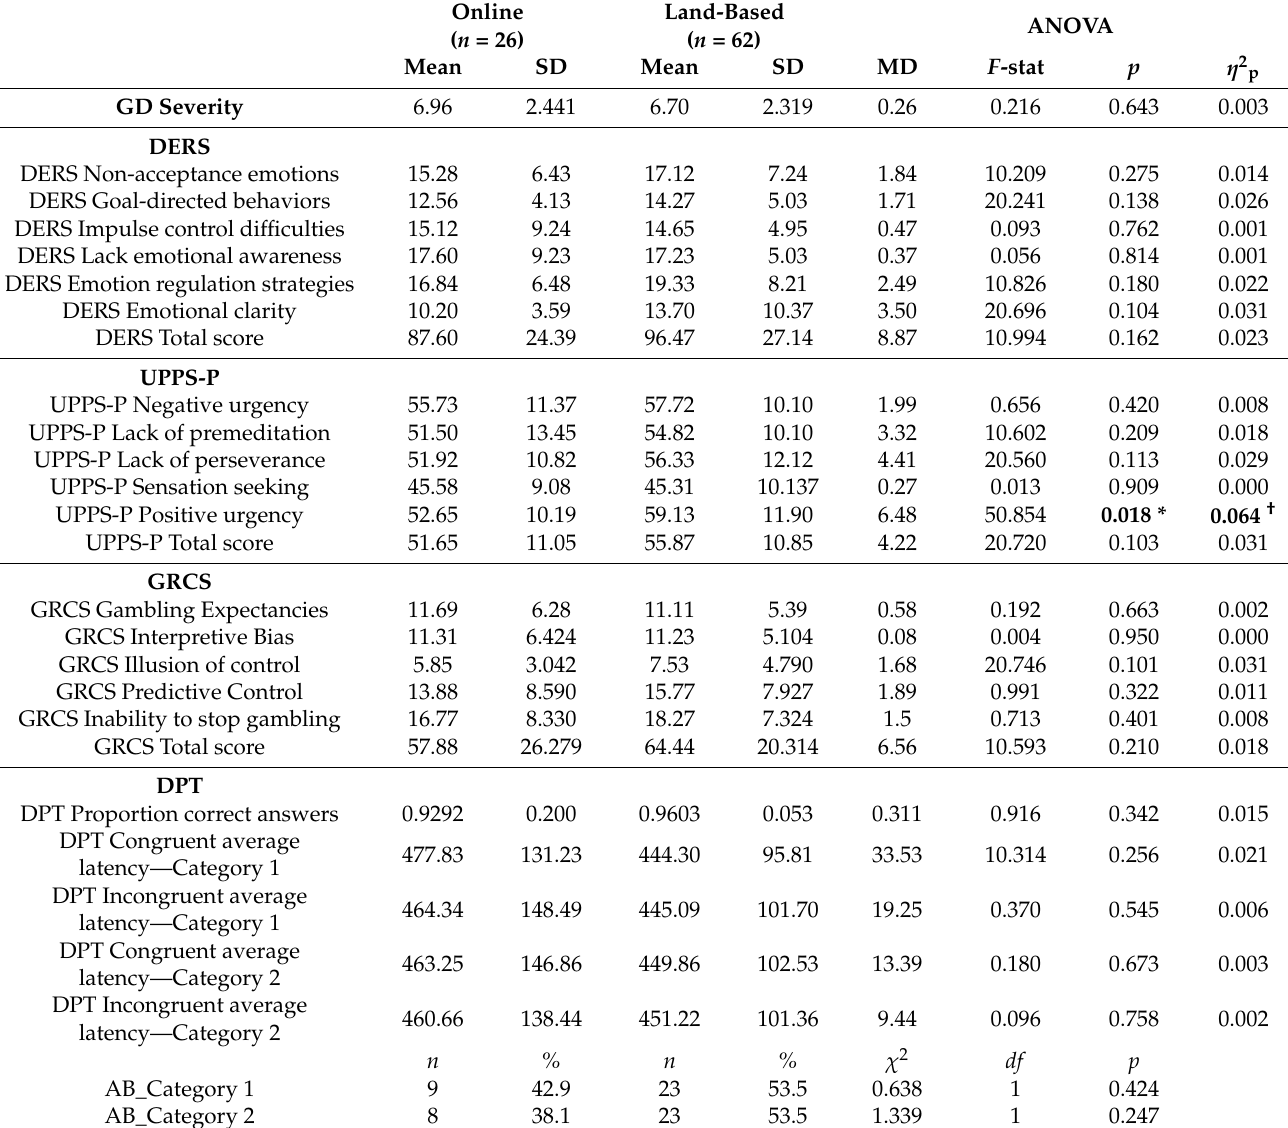
Table 3. Comparison between online and land-based gambling subgroups regarding DERS, UPPS-P, GRCS, and DPT scores. Online ( n = 26)